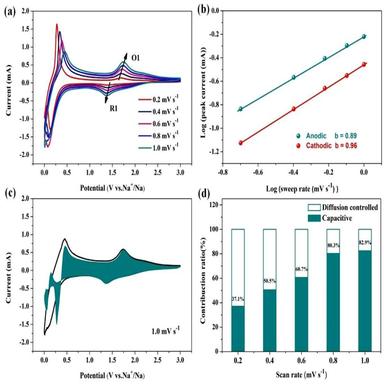
(a) CV curves of NC/MoSe2@NC electrode at different scan rates; (b) log (sweep rates) versus log (peak currents) plots of anodic and cathodic peaks; (c) Pseudocapacitive contribution (shaded region) in the CV curves at 1.0 mV s−1; (d) different contribution ratio of diffusion-controlled and pseudocapacitive charges under various scan rates.